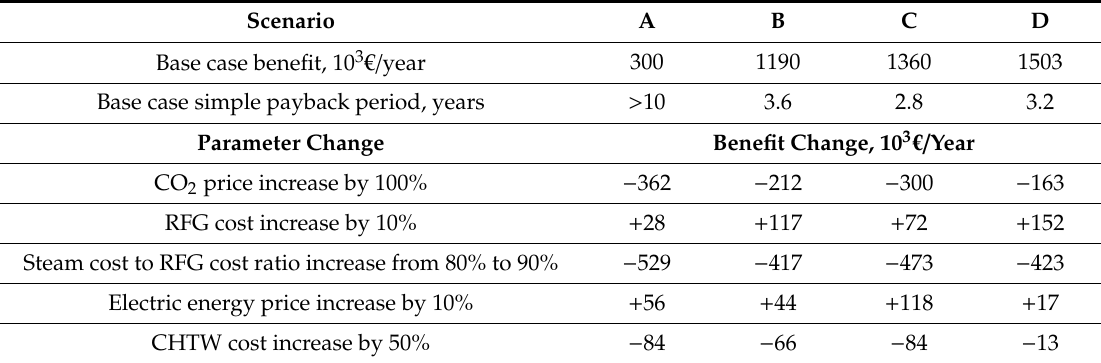
Table 14. Sensitivity analysis of benefit change; base case definition: c RFG = € 7 / GJ, c steam = 0.8. c RFG